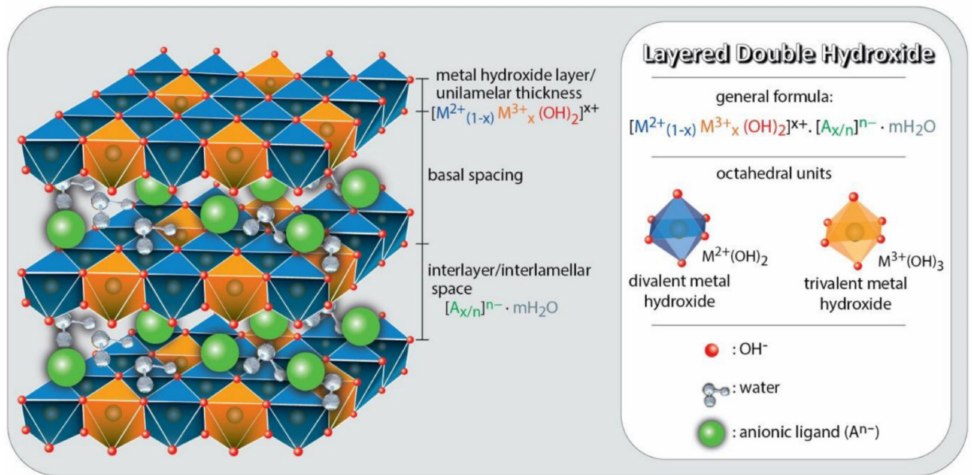
Figure 1. Schematic illustration of the chemical composition and structure of layered double hydrox- ides (LDHs) (Reprinted from [32] with permission of Elsevier,